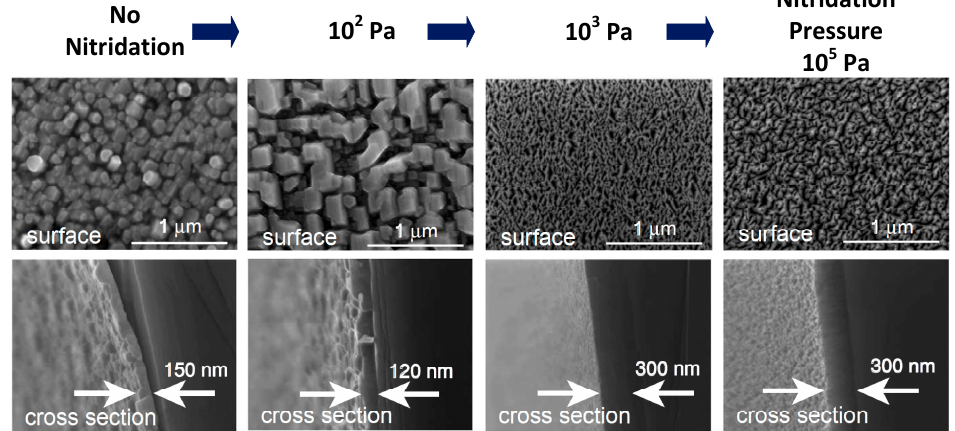
Figure 8. Field emission scanning electron microscope (FESEM) images of surface morphology and cross section of deposited GaN layers as a function of the nitridation pressure. Reprinted with